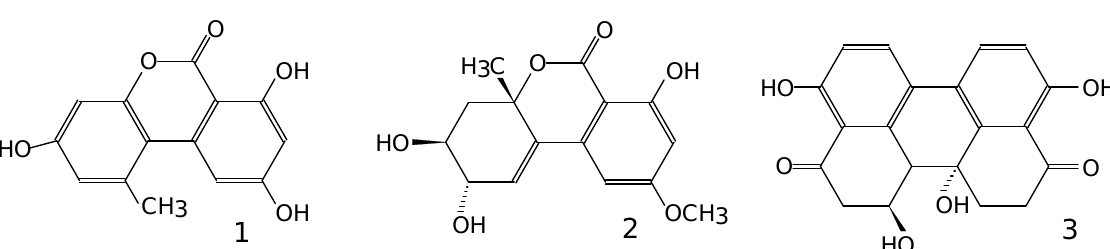
Figure 4. Structures of some Alternaria mycotoxins: alternariol {AOH} (1), altenuene {ALT}(2), altertoxin I{ATX-I}(3).